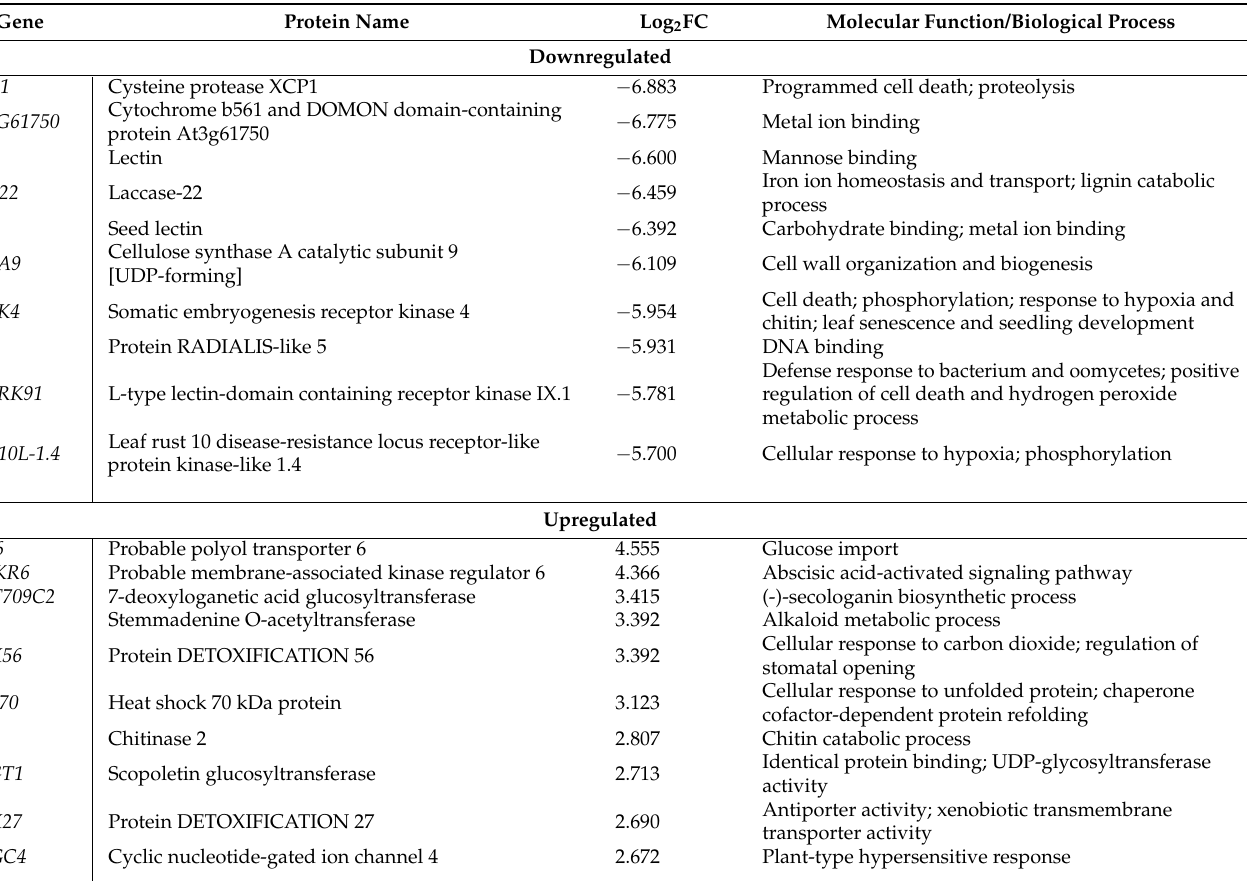
Table 3. Top 10 most down and upregulated differentially expressed genes (DEGs) in non-nodulated Casuarina glauca plants supplied with KNO 3 (KNO 3+ ), grown at 600 mM NaCl relative to the control (0 mM NaCl), ordered by log2 fold-change (log2FC). NBCI gene symbol, protein name, log2FC and respective Gene Ontology (GO) molecular function(s) and biological process(es) retrieved from UniprotKB database. Protein names coloured in blue are also on the top 10 most down or upregu- lated DEGs, respectively, at 600 mM NaCl in plants nodulated by nitrogen-fixing Frankia casuarinae Thr (NOD + ).